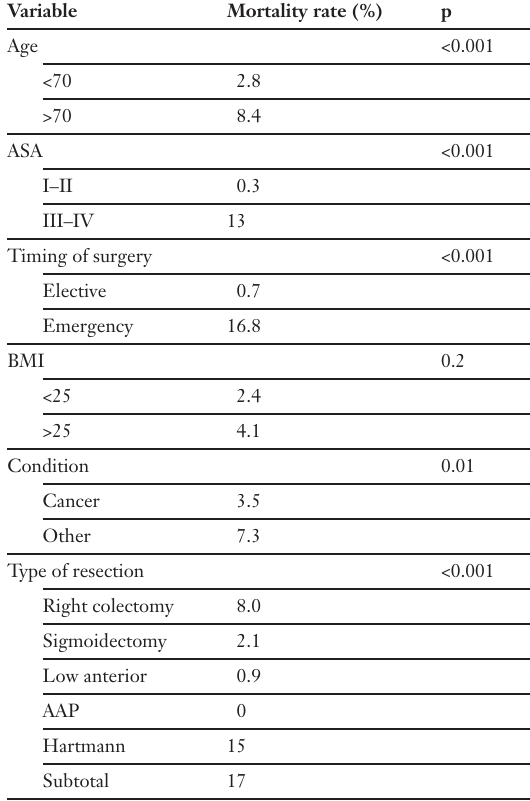
Univariate analysis of risk factors associated with